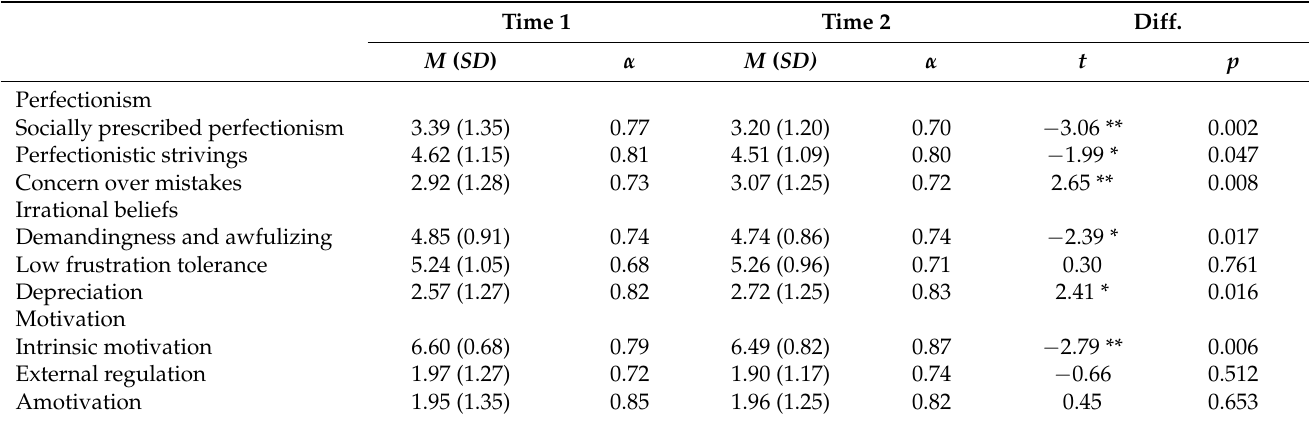
Table 1. Descriptive statistics and mean comparisons for the variables of irrational beliefs, perfection- ism, and motivation for time 1 and time 2. Time 1 Time 2 Diff. M ( SD ) α M (